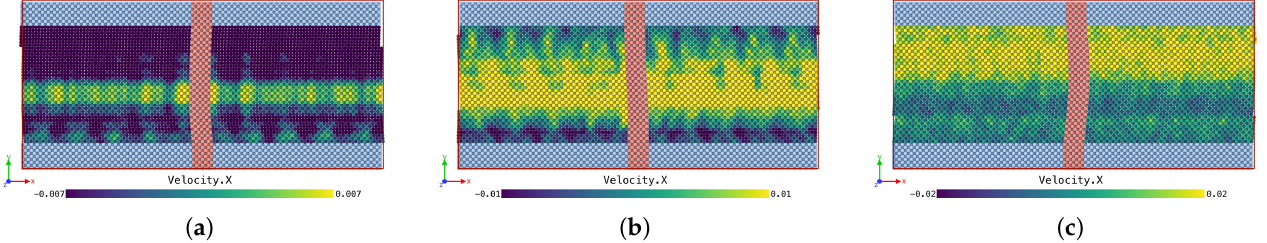
Figure 12. Set of particles tracked during the oscillatory test in a pure elastic substance. Example of a limiting stable case. Longitudinal waves below stability threshold. ( a ) t = 3.9 × 10 − 4 s. ( b ) t = 4.3 × 10 − 4 s. ( c ) t = 7.8 × 10 − 4 s.